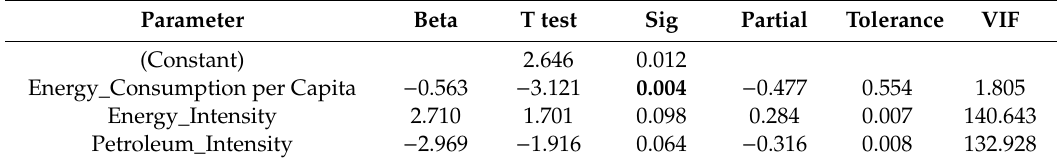
Table 12. Multicollinearity and partial correlation of parameters from the Energy Use Intensity group.